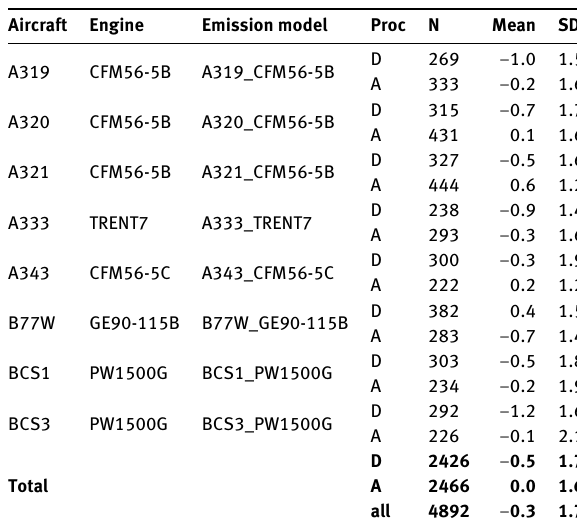
Table 1: Differences between simulation and measurements (ZRH and GVA combined) for all full models, separated into departures (D) and approaches (A). N: number of noise events; SD: standard